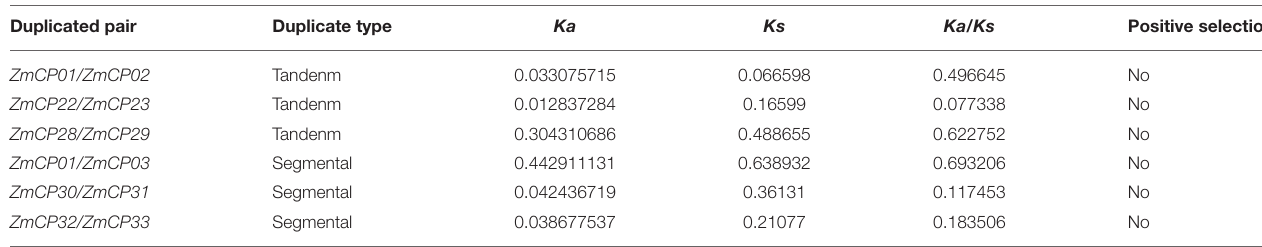
TABLE 2 | Non-synonymous ( Ka) /synonymous ( Ks) analysis of ZmCPs in maize. Duplicated